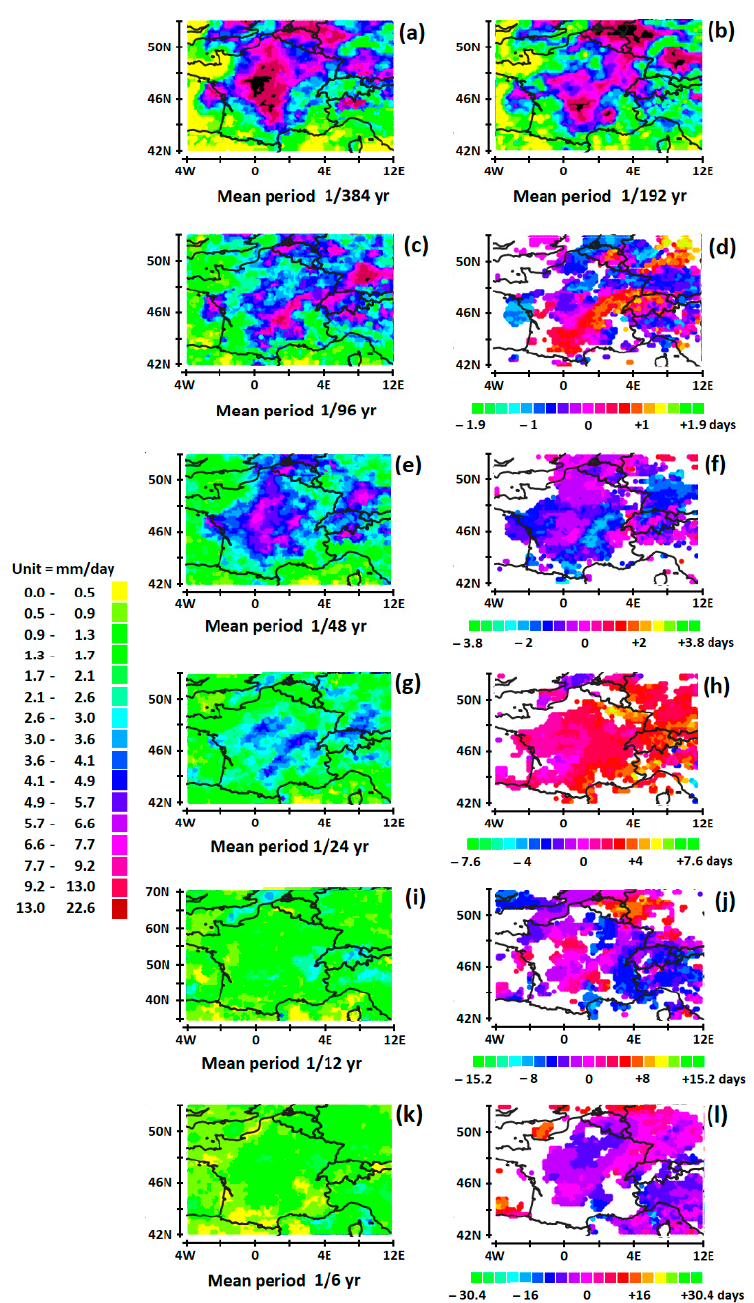
Figure 5. Extreme rainfall in Western Europe. The amplitude ( a – c , e , g , i,k ) and the phase ( d , f , h , j,l ) of the precipitation depth within the 7 period ranges. The calculation of the amplitude and the phase according to the harmonics 1/384 and 1/192 requires an over-sampling of the data. Each daily time step is divided into 8 equal parts assuming a Gaussian distribution of precipitation. The phases related to those harmonics are not represented, because the periods are close to the sampling step. The amplitudes are expressed in 16 classes each containing the same number of ordered data (quantiles). For each period range, the color of the bar associated with the phase divides the mean period in 18 intervals. Time lags in ( b , d , f , h,j ) are expressed in relation to 2 June 2016. The time reference is the rainfall depth at 46 ◦ N, 6 ◦ E. Only the phase corresponding to the 50% quantile of the highest values of the amplitude is displayed.